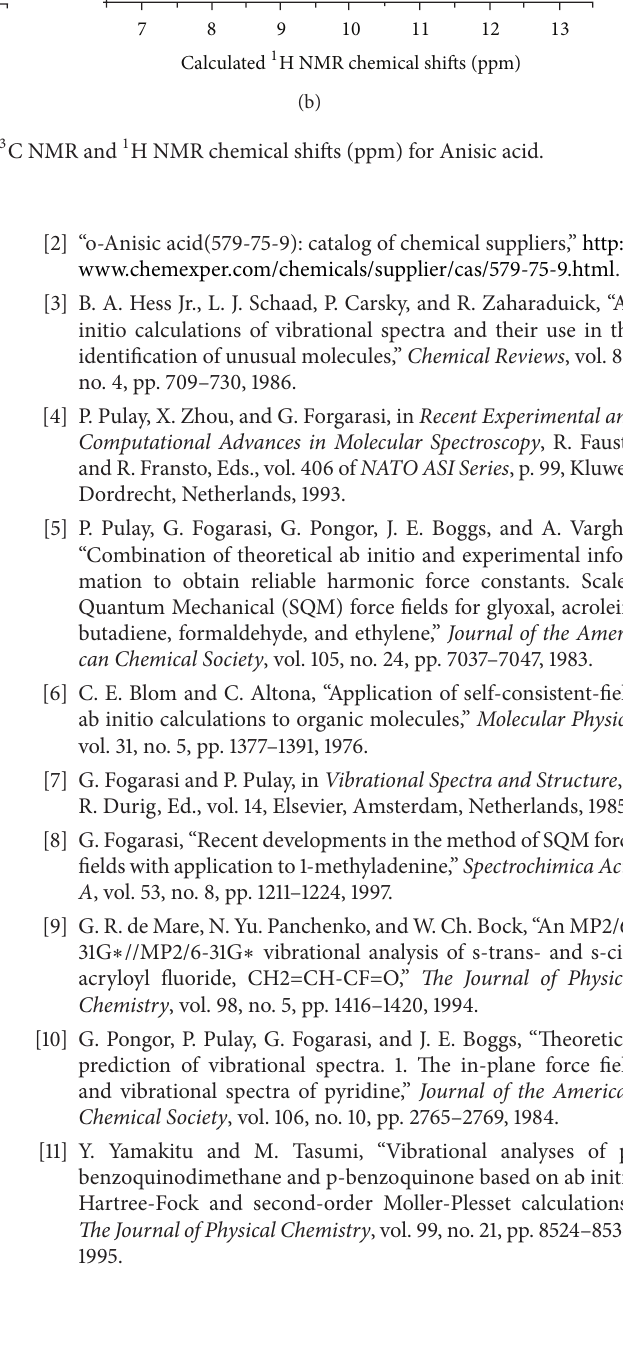
Figure 9: Plot of the calculated versus the experimental 13 C NMR and 1 H NMR chemical shifts (ppm) for Anisic acid.